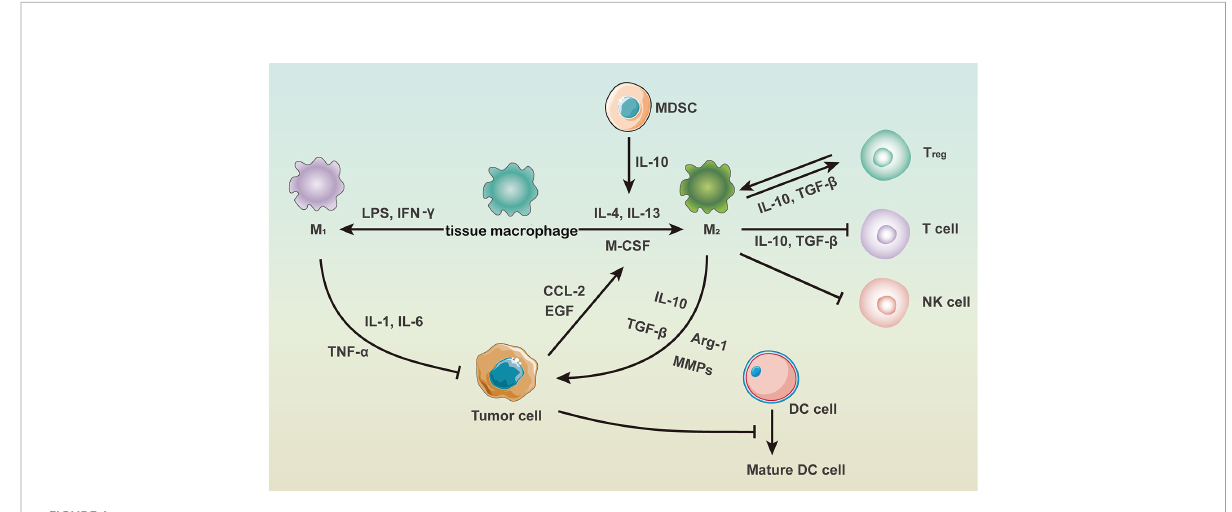
FIGURE 1 The role of macrophages in the immunosuppressive tumor